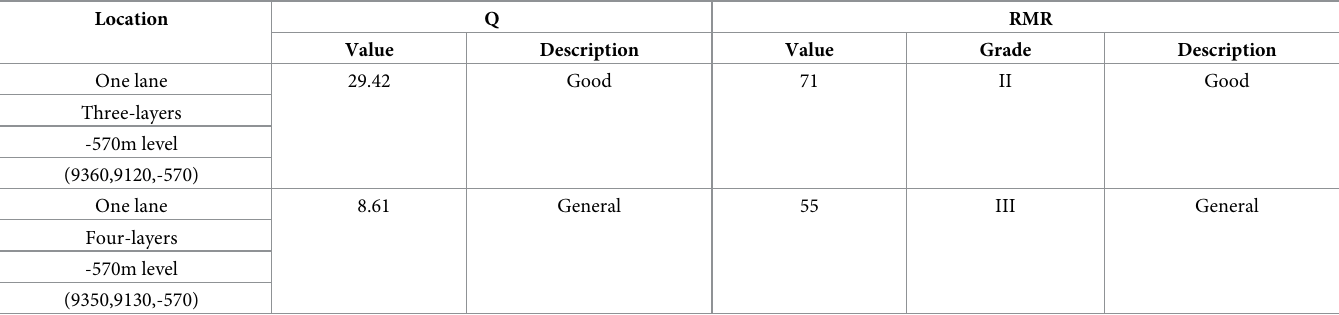
Table 5. Rock classification summary.